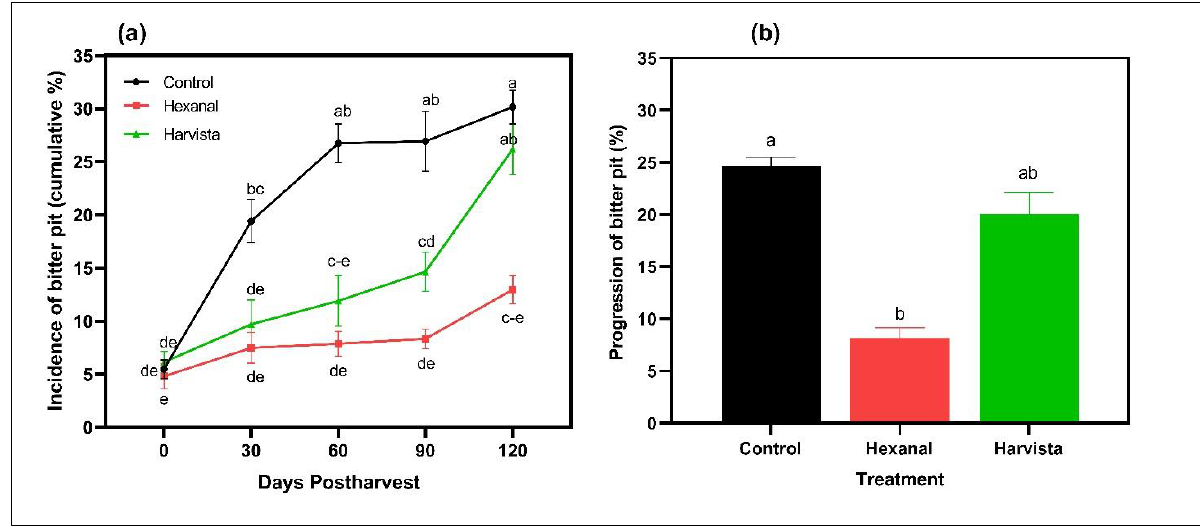
Figure 3. Effects of preharvest sprays hexanal and Harvista TM on ( a ) incidence and ( b ) progression of bitter pit (BP) in ‘Honeycrisp’ apple throughout 120 days postharvest. Incidence of BP was calculated based on visual observation on present or absent of BP signs in the fruit. Progression of BP was calculated based on the difference in incidence of BP between 0 days postharvest and 120 days postharvest. Each value represents the least-squares means ± SE of three replications, and each replication had 14 fruit. LS-means with the same letters are not significantly different when comparing treatments with days postharvest based on the Tukey-Kramer test at α = 0.05.